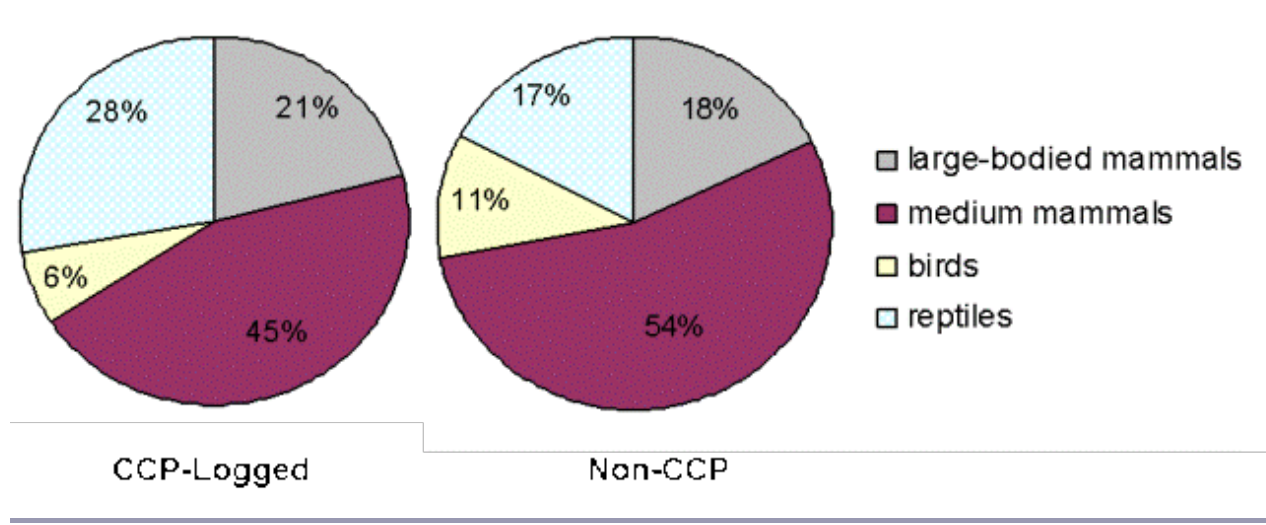
Fig. 2. Hunting rates in CCP-logged and non-CCP communities by game animal type. Large mammals include peccaries, deer, tapir, and monkeys. Medium mammals include armadillos, agouti, paca, and other large rodents. Birds include all game birds. Reptiles include